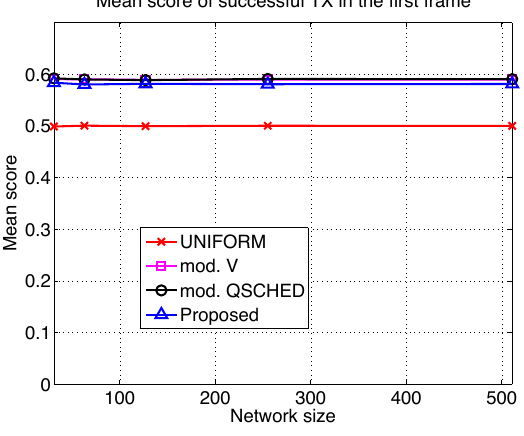
Figure 11. Mean score of successful transmissions in the first frame when m = 20 and b = 3